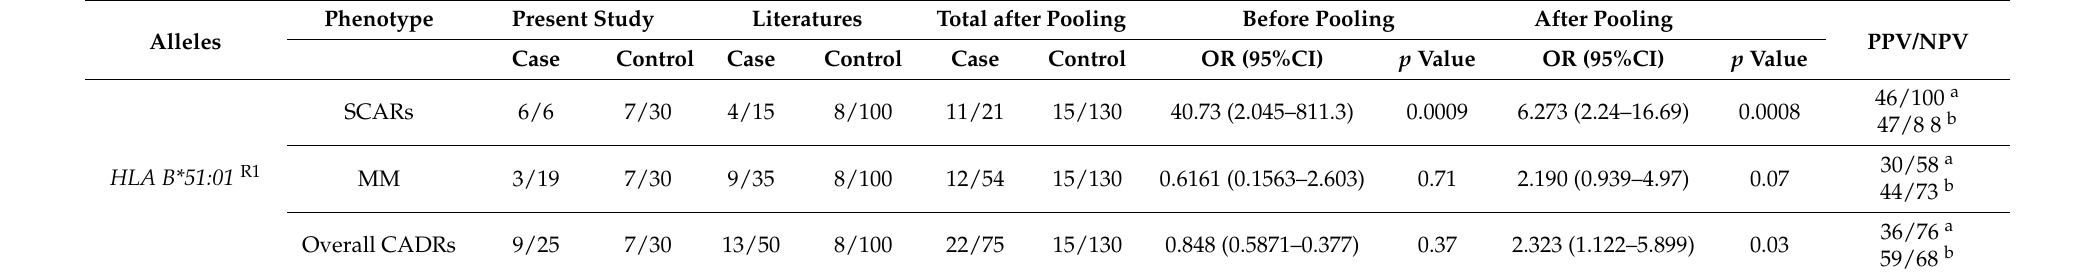
Table 3. Pooled data analysis for HLA B*51:01 and